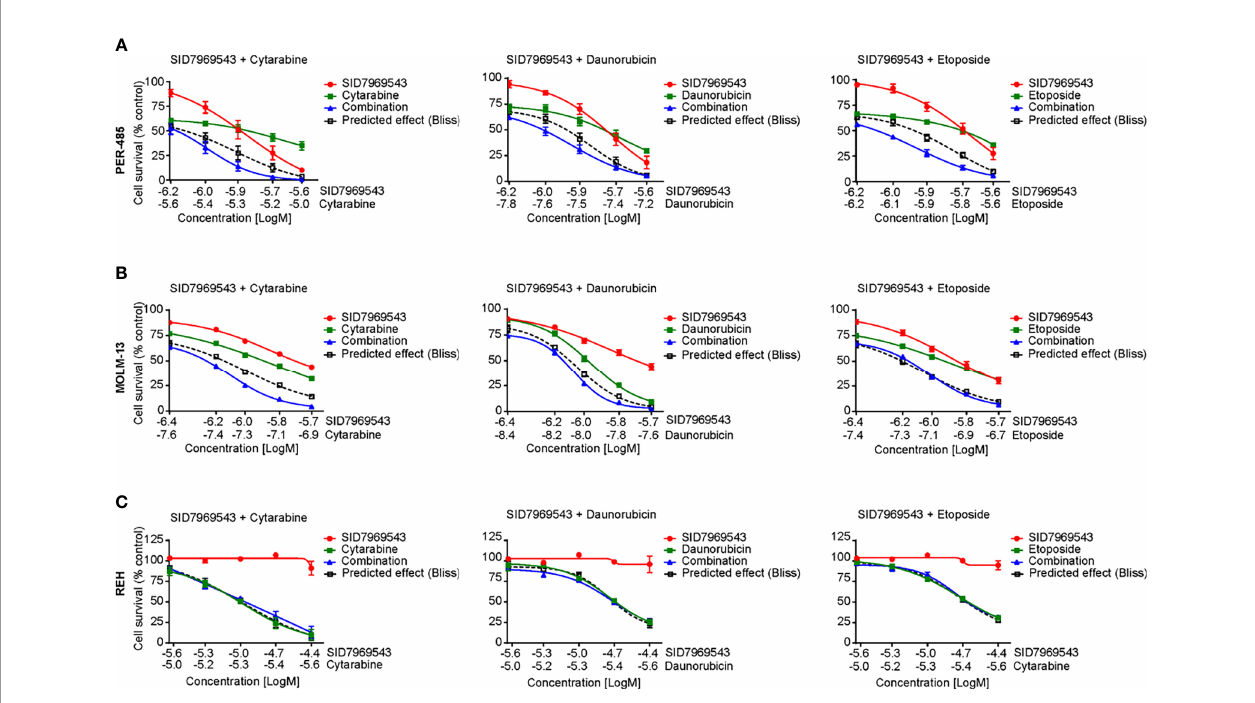
FIGURE 4 | SID7969543 synergizes with conventional chemotherapeutics. Dose response curves for combination treatments of SID7969543 and standard-of-care chemotherapy drugs cytarabine, daunorubicin and etoposide in PER-485 (A), MOLM-13 (B) and REH (C) cells as determined by 72-hour resazurin-based viability assays. Graphs depict mean ± SE of three independent experiments. Drug synergy was calculated by applying the Bliss additivity model. Dotted lines indicate predicted viability if compounds are additive and combination curves below the dotted Bliss line indicate the occurrence of synergy between the tested